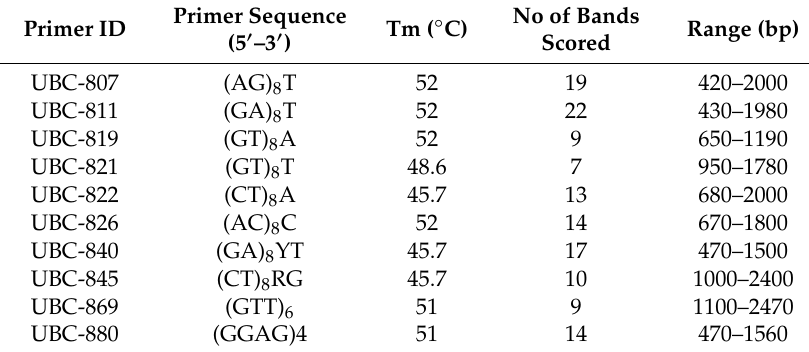
Table 2. Primers used for ISSR analysis; primers’ sequences; annealing temperatures; number and range of bands scored for each primer